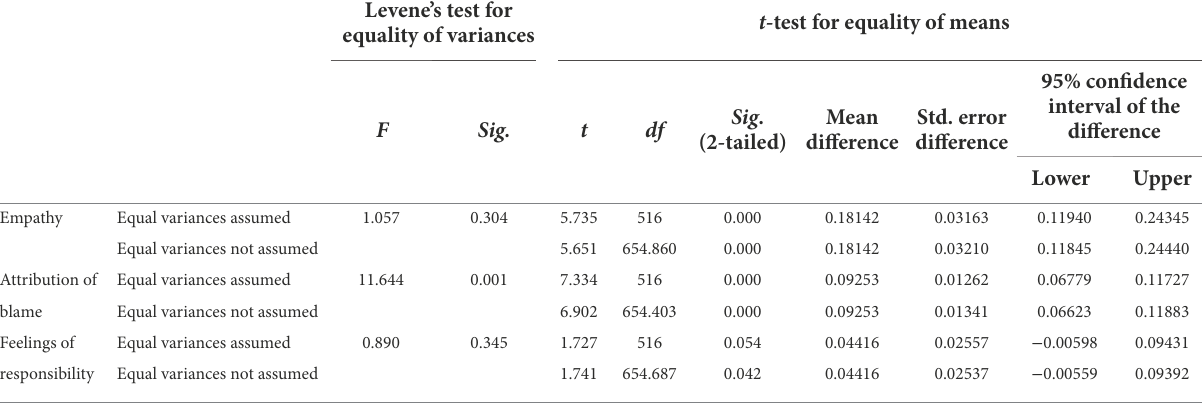
TABLE 6 T -test results for differences in empathy, attribution of blame, and feeling of responsibility for parents and teachers. Levene’s test for equality of variances